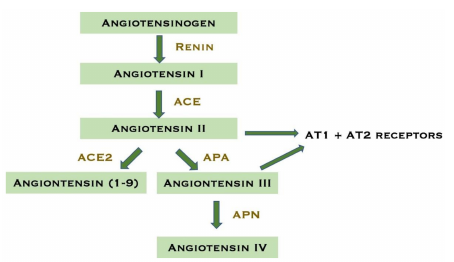
Figure 1. Schematic diagram of the brain renin–angiotensin system. Abbreviations: Angiotensin-converting enzyme (ACE), angiotensin-converting enzyme type 2 (ACE2), aminopeptidase A (APA),